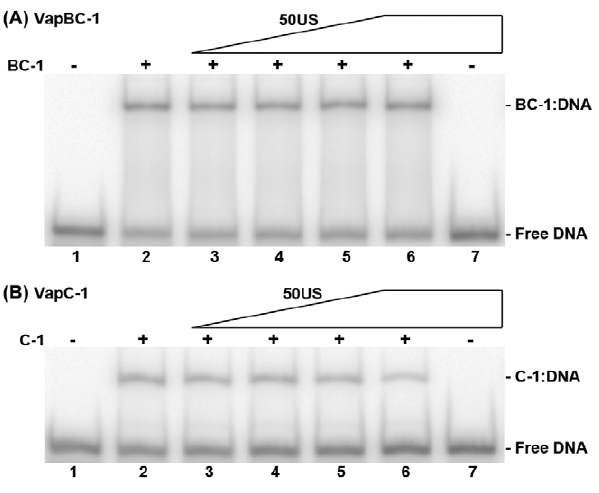
Figure 7. Competition binding of 50TIR and 50US by Vap proteins. Gel shift products from addition of 50US substrate into samples containing 50TIR substrate and either (A) VapBC-1 or (B) VapC- 1 at a 150:1 molar ratio of VapC-1 protein to DNA. VapB-1 and VapC-1 are at a 3:1 molar ratio in the VapBC-1 samples, but VapC-1:DNA molar ratios are reported since VapC-1 is the DNA binding protein and the actual amount of VapBC-1 complexes cannot be determined. The gels show the products of the following samples: 50TIR without protein ( lane 1 ), protein with only 50TIR ( lane 2 ), the addition of a 1:1, 5:1, 10:1 or 50:1 molar ratio of cold 50US:50TIR ( lanes 3–6 ), and DNA only at 50:1 molar ratio of 50US:50TIR ( lane 6 ). The identity of each band is noted at the right of each gel. Each gel represents one of two independent experiments.